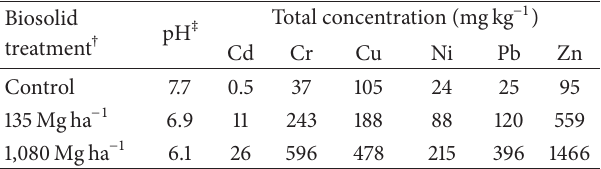
Table 1: Chemical properties of the soil used for the